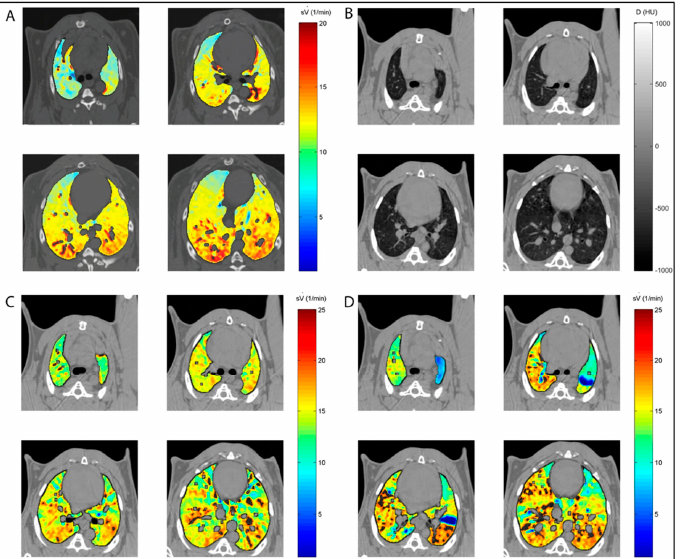
Figure 6. Dual-energy KES CT imaging with SXR. ( A ) Control rabbit, ( B ) lung morphology, ( C ) animal with methacholine (MCH)-induced bronchoconstriction at baseline and ( D ) animal with methacholine (MCH)-induced bronchoconstriction at baseline during the challenge. Reprinted with permission from [22].